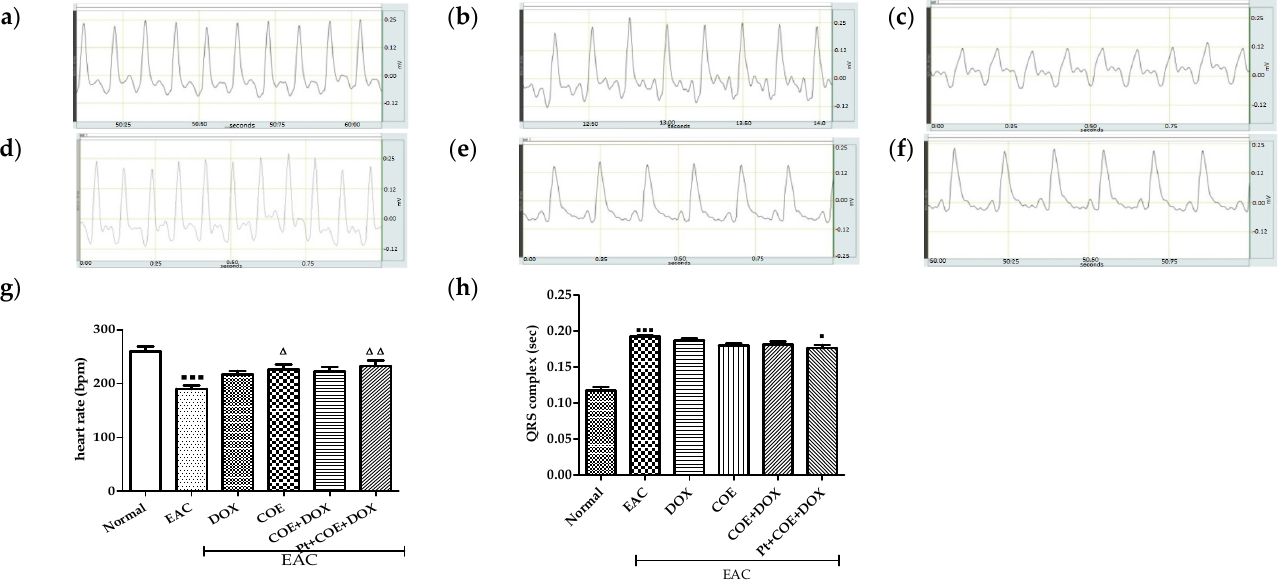
Figure 2. Effect of COE on ECG on doxorubicin-induced cardiomyopathy in EAC-induced carcinoma. Qualitative analysis of ECG of all the experimental groups; ( a ) Normal, ( b ) EAC, ( c ) DOX, ( d ) COE, ( e ) COE + DOX, ( f ) Pt + COE + DOX, ( g ) effect on heart rate, ( h ) effect on QRS complex. All values are expressed as the mean ± SEM (n = 6). Data were analysed using a one-way analysis of variance (ANOVA) followed by Tukey’s test. ▀ ▀ ▀ p < 0.001, compared with normal; Δ p < 0.05, ΔΔ p < 0.01, compared with EAC.